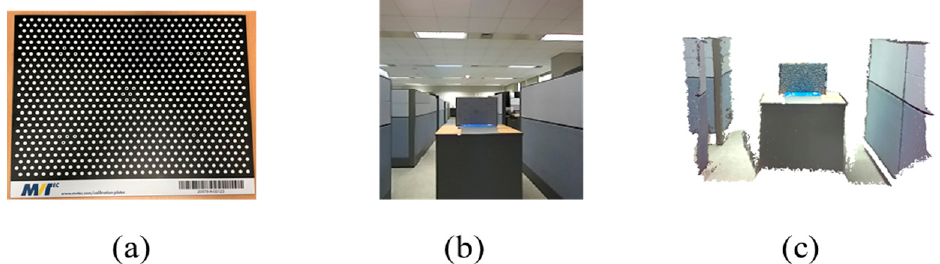
Figure 4. Testing accuracy by distance configuration: ( a ) Halcon calibration plate; ( b ) scanned image; ( c ) reconstructed 3D pointcloud.